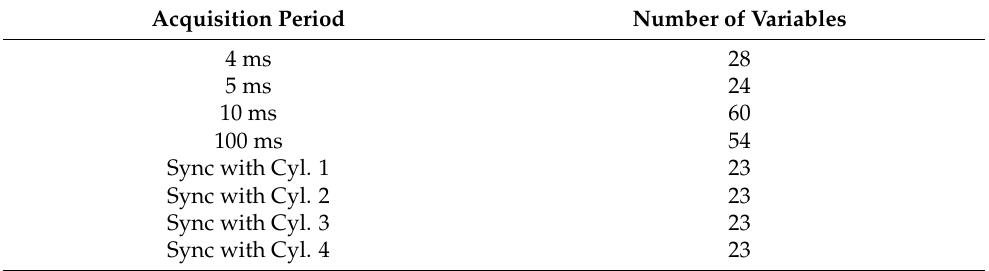
Table 2. Experiment variables details.